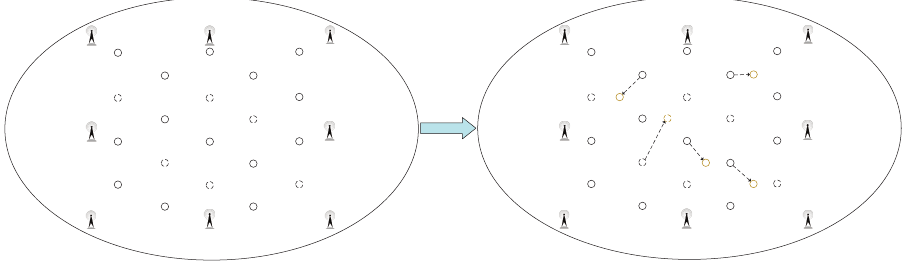
Figure 10. The Dynamic Changes to the Realistic Environment.